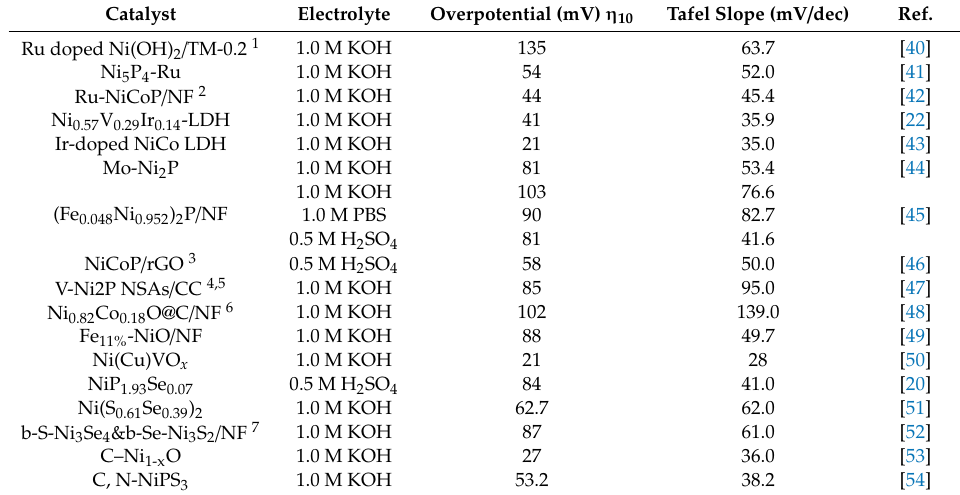
Table 1. HER performances of various doped nickel-based electrocatalysts.